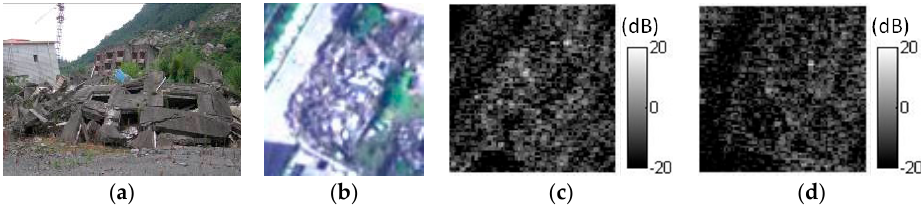
Figure 2. A collapsed building: ( a ) in situ photograph; ( b ) optical image acquired in 2013; ( c ) TerraSAR-X ST ascending SAR image (the azimuth direction is from bottom to top, and the range direction is from left to right); ( d ) TerraSAR-X ST descending SAR image (the azimuth direction is from top to bottom, and the range direction is from right to left).